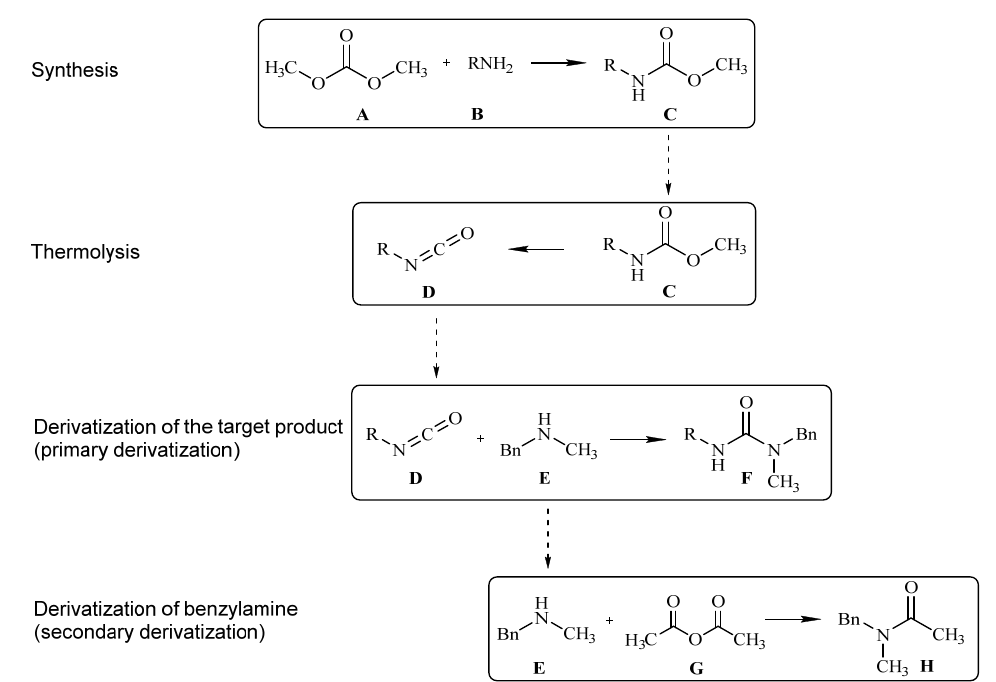
Figure 1. Chemical reactions during the process under study.